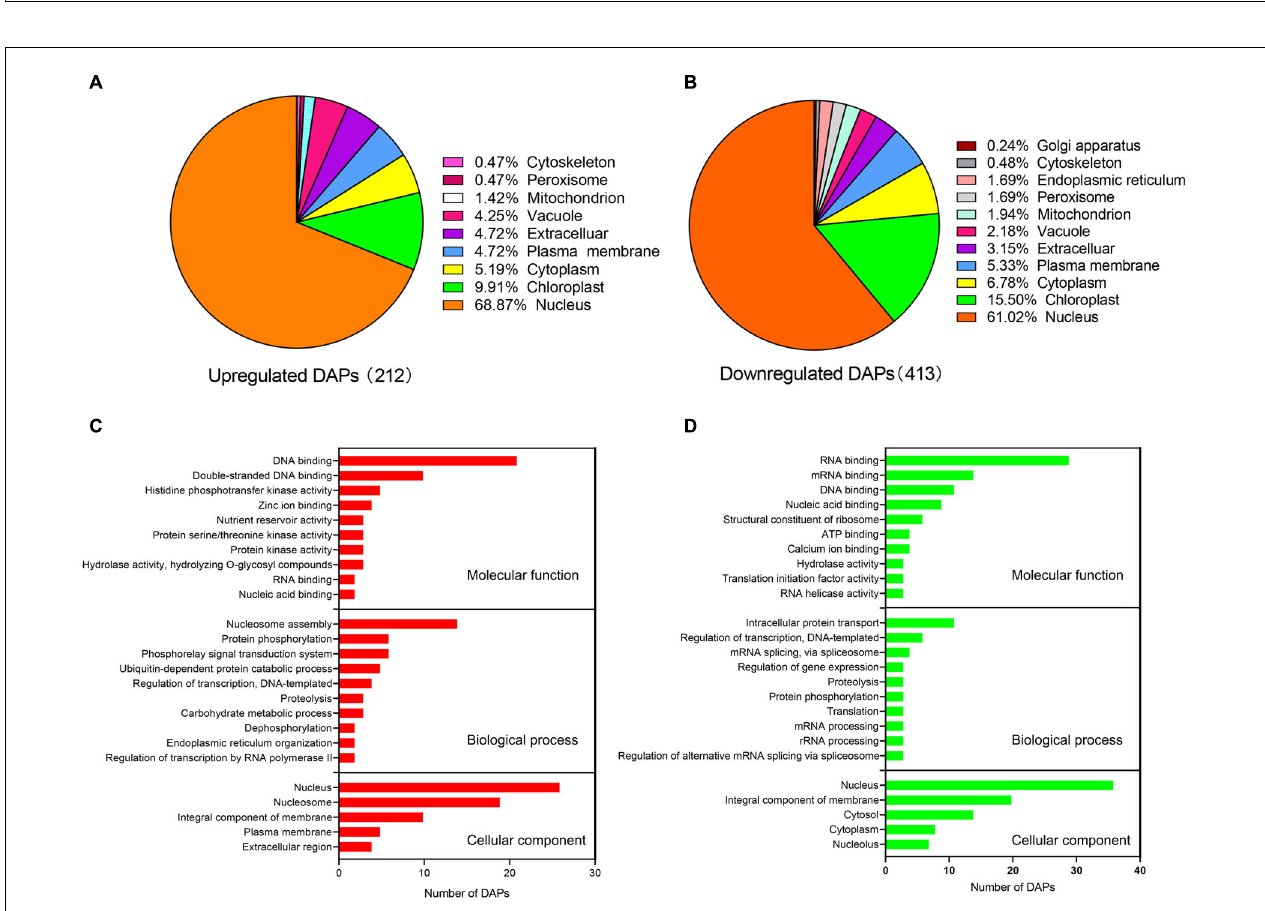
FIGURE 3 | Subcellular localization and GO annotation of differentially accumulated proteins (DAPs) identified from wheat nucleus under water deficit. (A) Subcellular localization of significantly up-regulated nuclear proteins. (B) Subcellular localization of significantly down-regulated nuclear proteins. (C) GO annotation of significantly up-regulated proteins. (D) GO annotation of significantly down-regulated